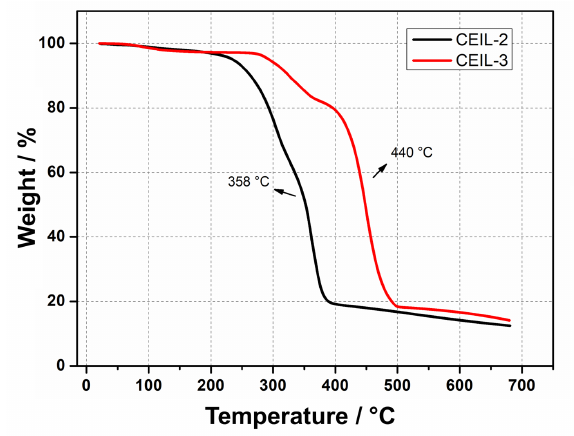
Figure 4. TGA thermograms of CEIL-2 and CEIL-3 monomers under a heating rate of 10 ◦ C · min − 1